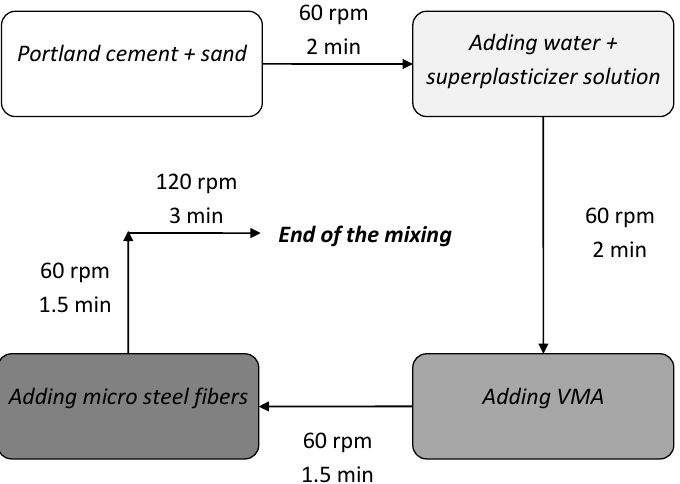
Figure 3. Mixing procedure of 3D printable mortars.